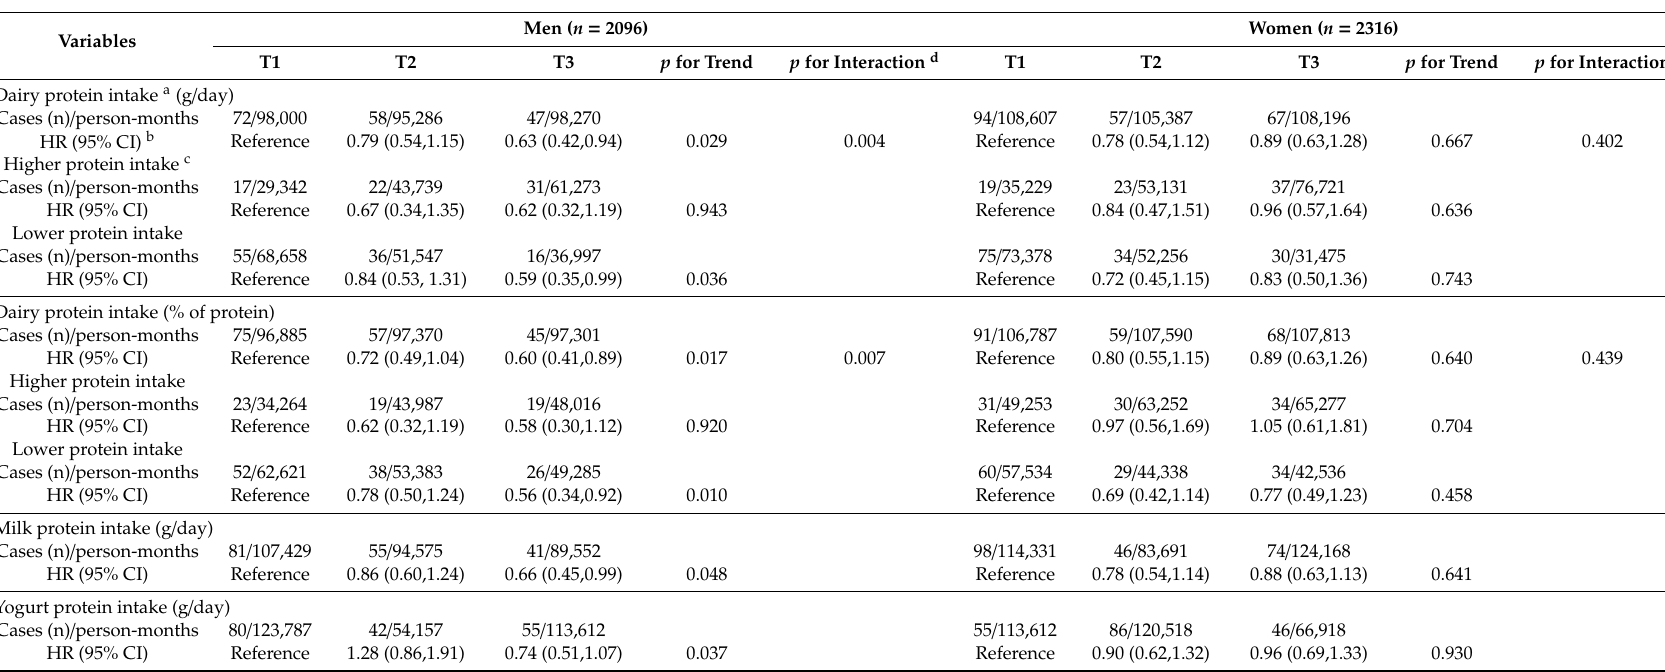
Table 3. Hazard ratios (HRs) and 95% confidence intervals (95% CIs) for the risk of developing a low SMI according to tertiles of dairy protein intake at baseline.